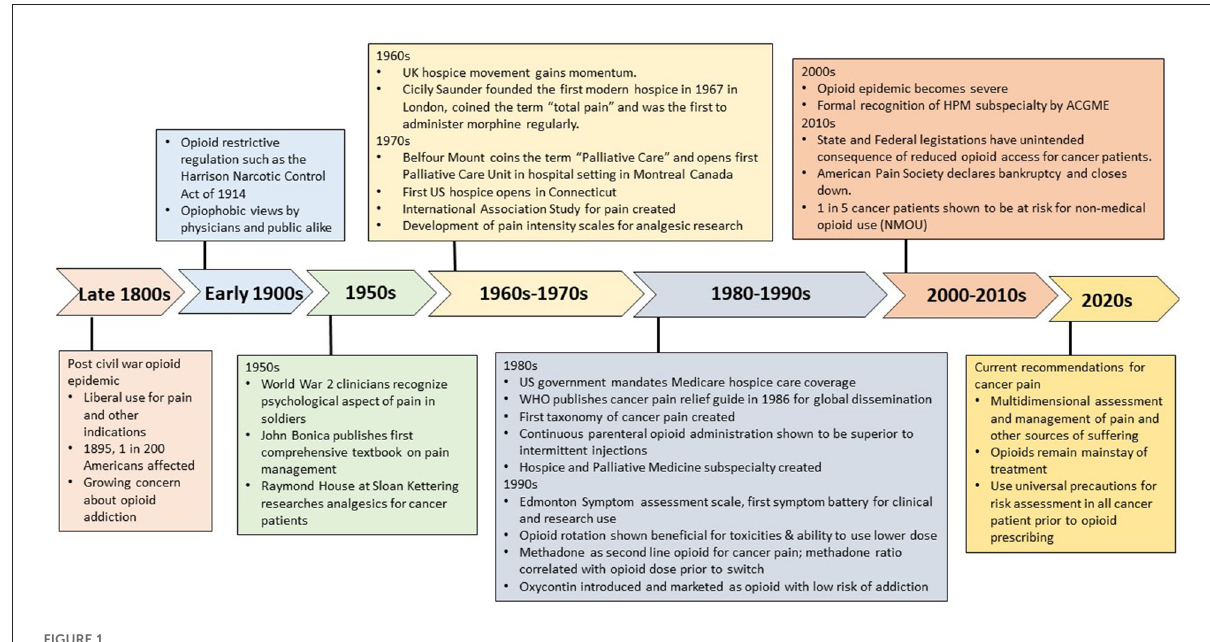
FIGURE1 Pivotal events in cancer pain